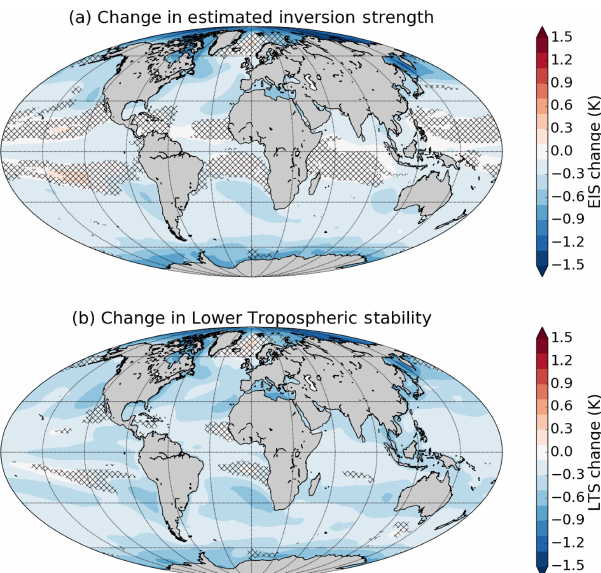
Figure 6. Multi-model mean changes in EIS (a) and LTS (b) for G1 – piControl. Hatching indicates areas where fewer than seven of nine models agree on the sign of the change. CSIRO-Mk3L-1-2 and MPI-ESM-LR models are excluded from this plot because near- surface specific humidity output, which is required to calculate EIS, was not